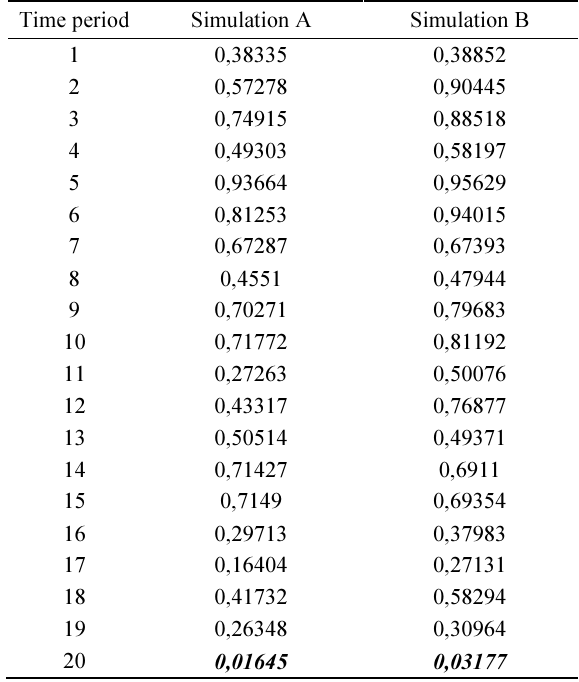
Table 4. P-value of the Kolmogorov–Smirnov test Time